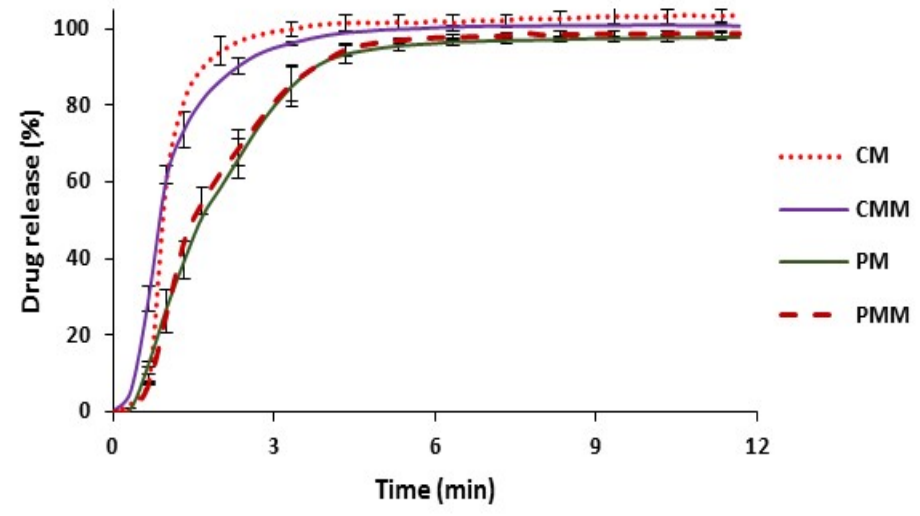
Figure 10. Dissolution profiles of CM (Cop AA-MCC/Melatonin), PM (Prosolv ODT/Melatonin), CMM (CM/MgSt), and PMM (PM/MgSt) tablets compressed at 5 kN.